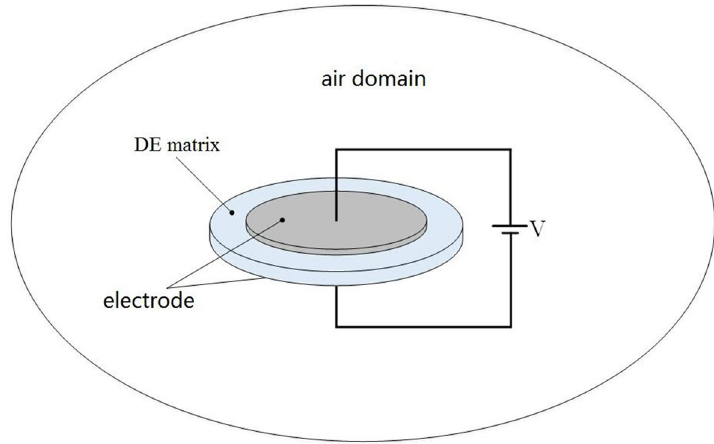
Figure 3. Schematic diagram of electrostatic model simulation.